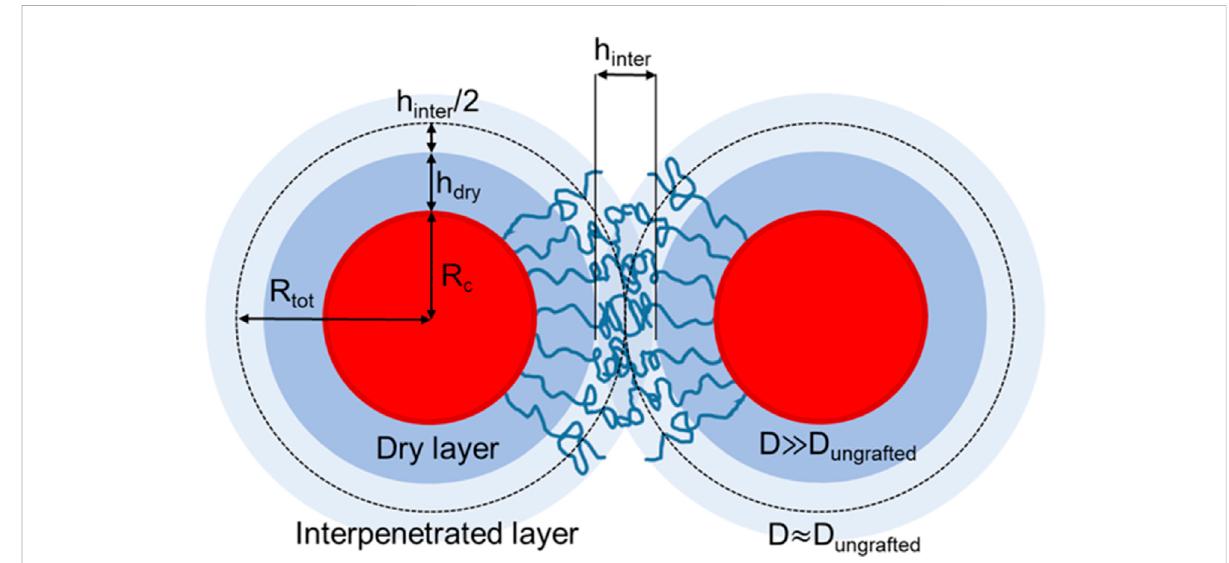
Schematic for the two-phase model of polymer grafted nanoparticle showing dry zone and interpenetrated zone. Reprinted with permission from Bilchak CR, Jhalaria M, Adhikari S, Midya J, Huang Y, Abbas Z, Nikoubashman A, Benicewicz BC, Rubinstein M, Kumar SK. Understanding